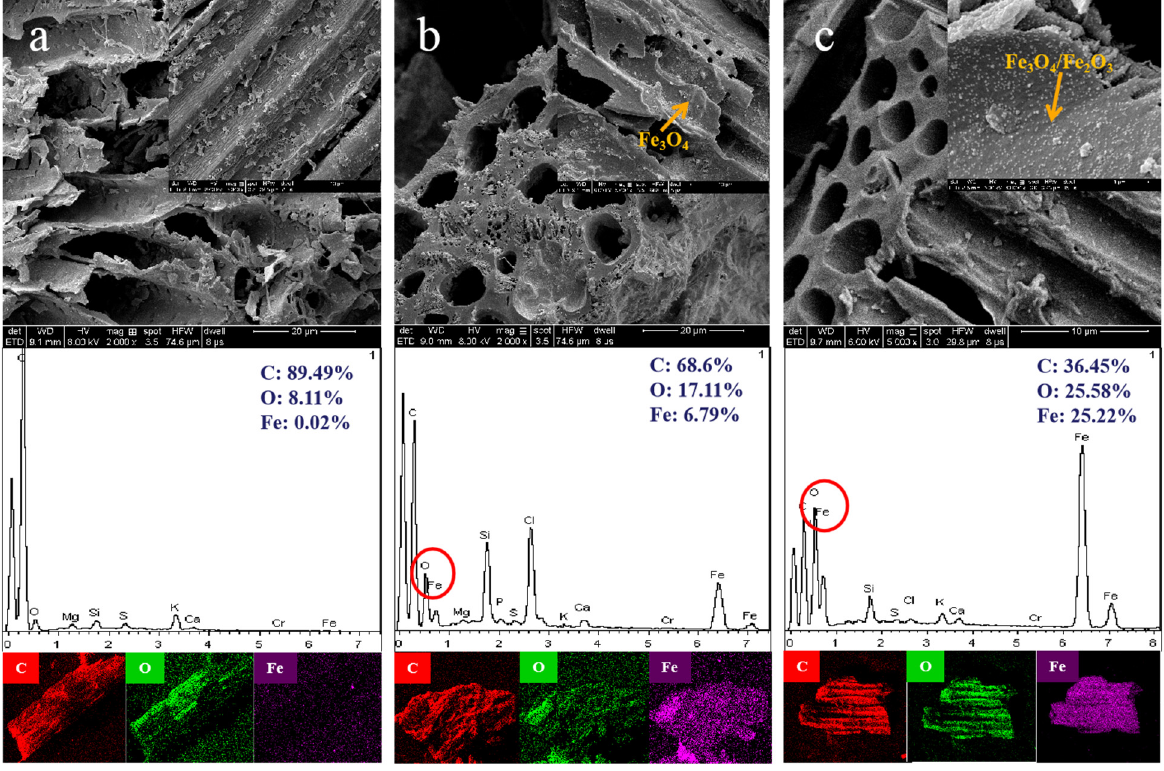
Figure 2. SEM- EDS analyses of BC ( a ), FeCl 3 @BC ( b ), and Fe(NO 3 ) 3 @BC ( c ). Figure 2. SEM-EDS analyses of BC ( a ), FeCl 3 @BC ( b ), and Fe(NO 3 ) 3 @BC ( c ). The FTIR spectrum (Figure 3a) demonstrated a wide peak of adsorption at 3000–3700 cm − 1 , related to stretching of -OH group of alcohols or phenols, in BC [14,27]. Moreover, the peak at 2920 cm − 1 was ascribed to the C-H vibration and peak at 2850 cm − 1 was due to CH x vibrations of aliphatic groups [2,28]. The peak at 1580 cm − 1 might be at- tributed to C=C and C=O stretching in the hydroxyl and lactone groups [29]. The distinctive peak at 1420 cm − 1 stated the presence of carboxylate group (O=C-O) [30] and 1107 cm − 1 were ascribed to the stretching of C-O [31,32]. The peaks between 700 and 900 cm − 1 were linked to C-H bending vibrations of aromatic group [33]. The functional groups such as -OH, -COOH, and -C-O could offer reaction sites for Cr(VI)